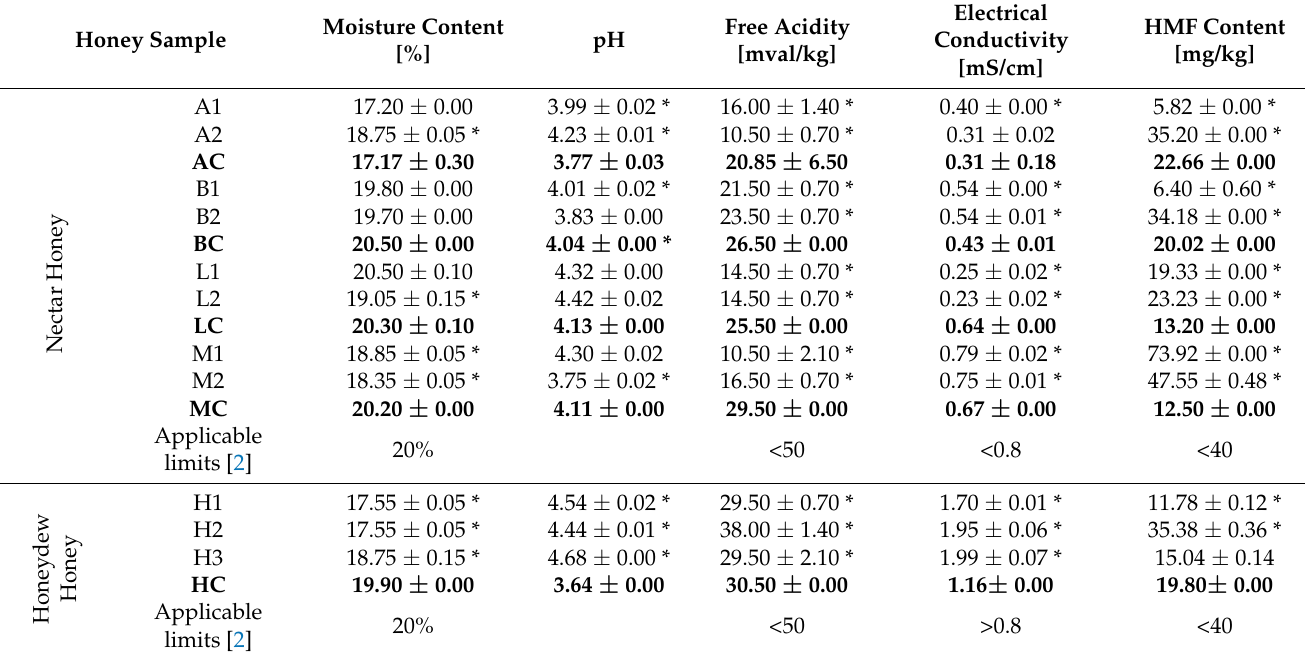
* Means marked with the symbol differ statistically significantly from a suitable high-quality local control sample (marked with bold): AC for acacia, BC for buckwheat, LC for linden, MC for multifloral, and HC for honeydew honey ( t -test, p <